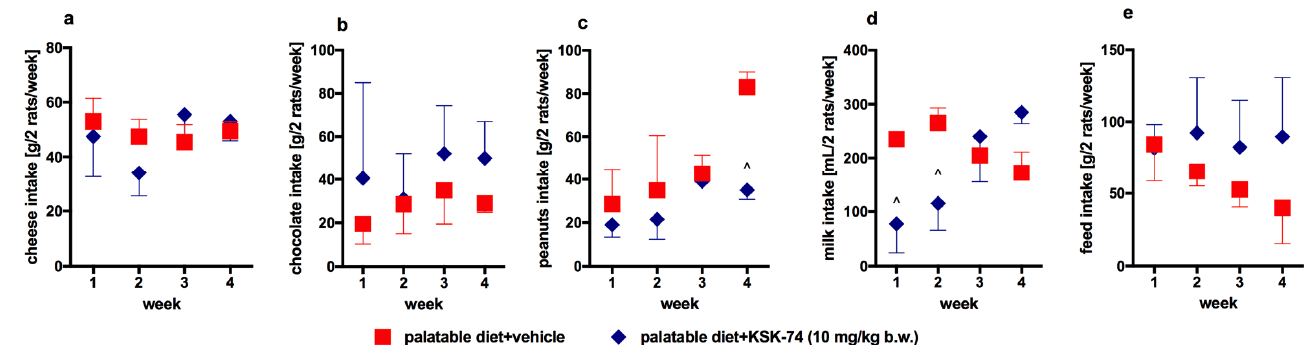
Figure 5. Amount of particular taste products’ intake: ( a ) cheese, ( b ) chocolate, ( c ) peanuts, ( d ) milk, ( e ) feed, by rats from group treated with KSK-74 compared to rats from control group fed palatable feed. Results are expressed as means ± SD, n = 3. Multiple comparisons were made using two-way ANOVA, Bonferroni’s post hoc tests. ^ Significant against the tested compound administered group vs. palatable diet + vehicle group; ^ p < 0.05.